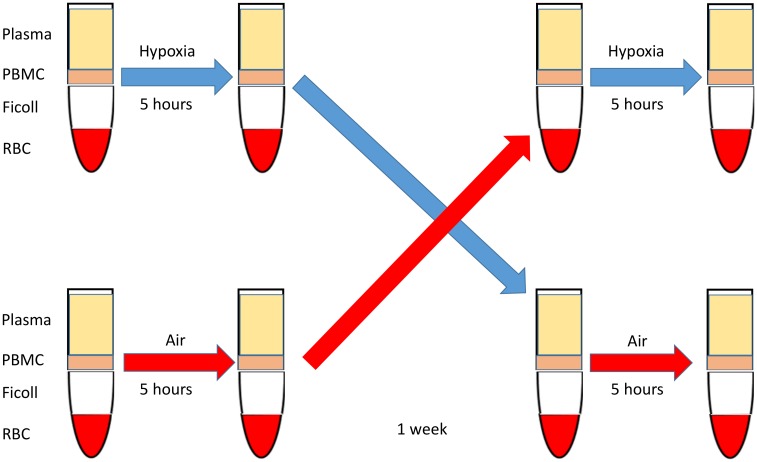
Cross-over study design.Healthy volunteers underwent phlebotomy in the antecubital fossa and whole blood (15 ml) was collected in the ethylenediaminetetraacetic acid (EDTA) coated tube. The volunteers were exposed to intermittent hypoxia or control air conditions (see Methods) for 5 hours followed by whole blood collection. In one week, the volunteers underwent phlebotomy again and had an alternative exposure followed by whole blood collection. Peripheral blood mononuclear cells (PBMC, lymphocytes and monocytes) were isolated immediately after blood collection using Ficoll-Hypaque solution. RBC, red blood cells.